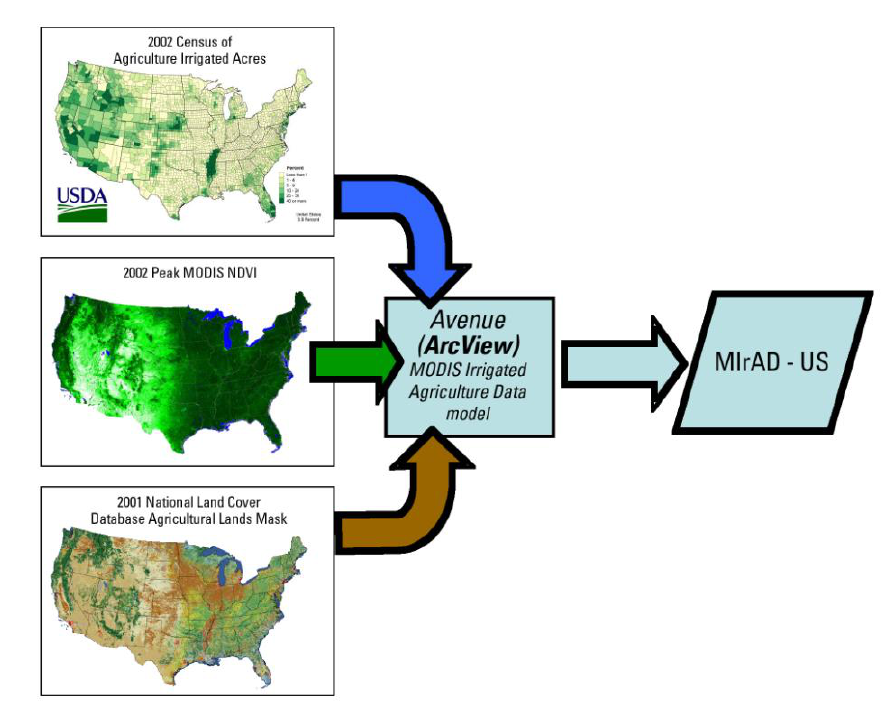
Figure 2. Schematic diagram of the Moderate Resolution Imaging Spectroradiometer (MODIS) Irrigated Agriculture Dataset (MIrAD-US)